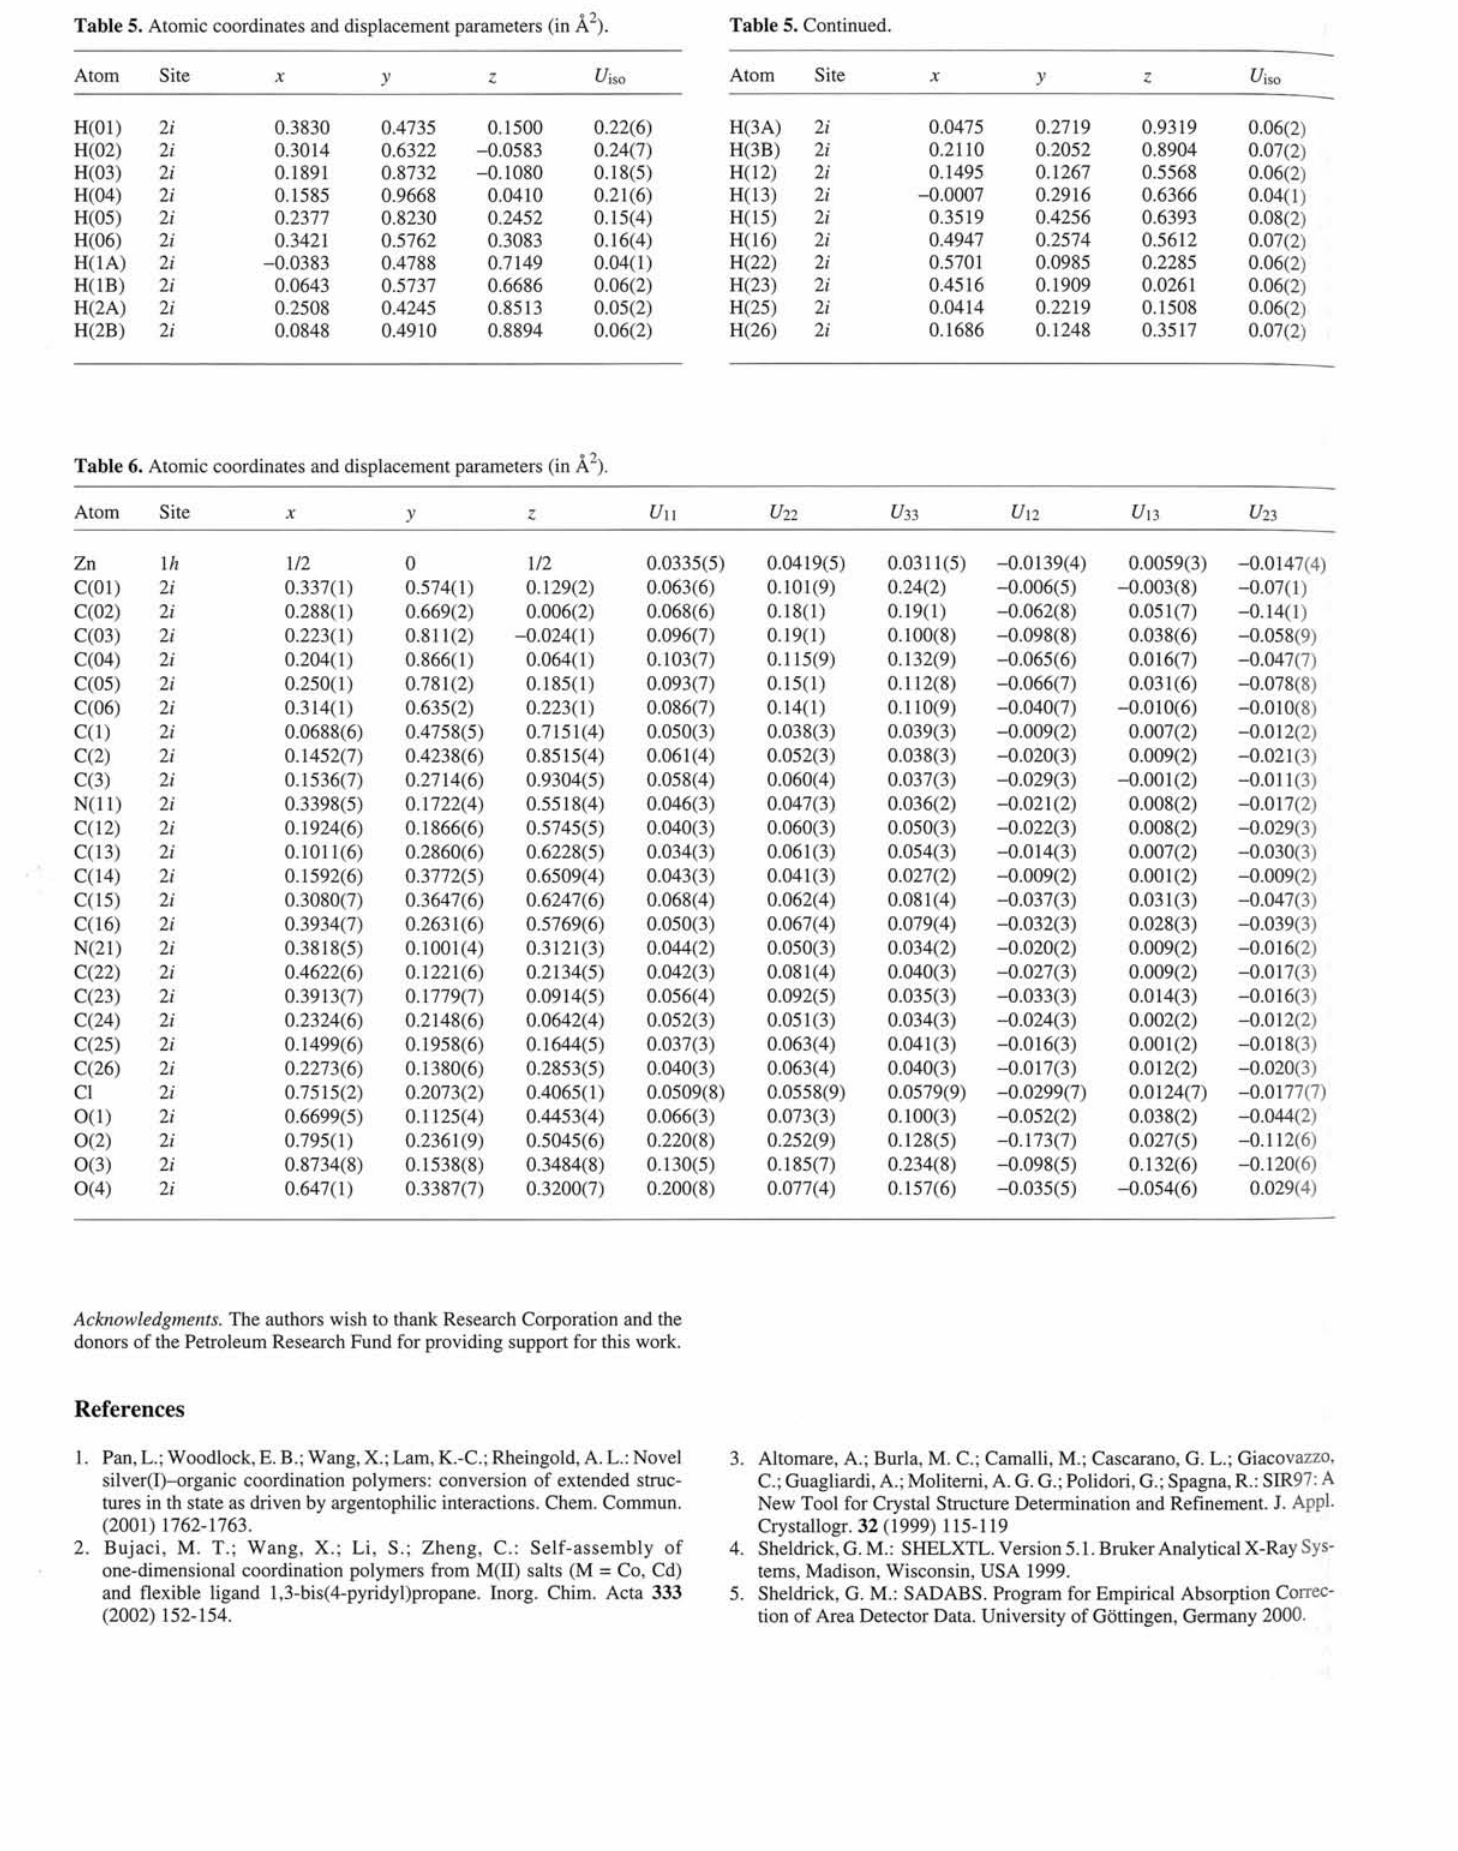
Table 6. Atomic coordinates and displacement parameters (in Á 2